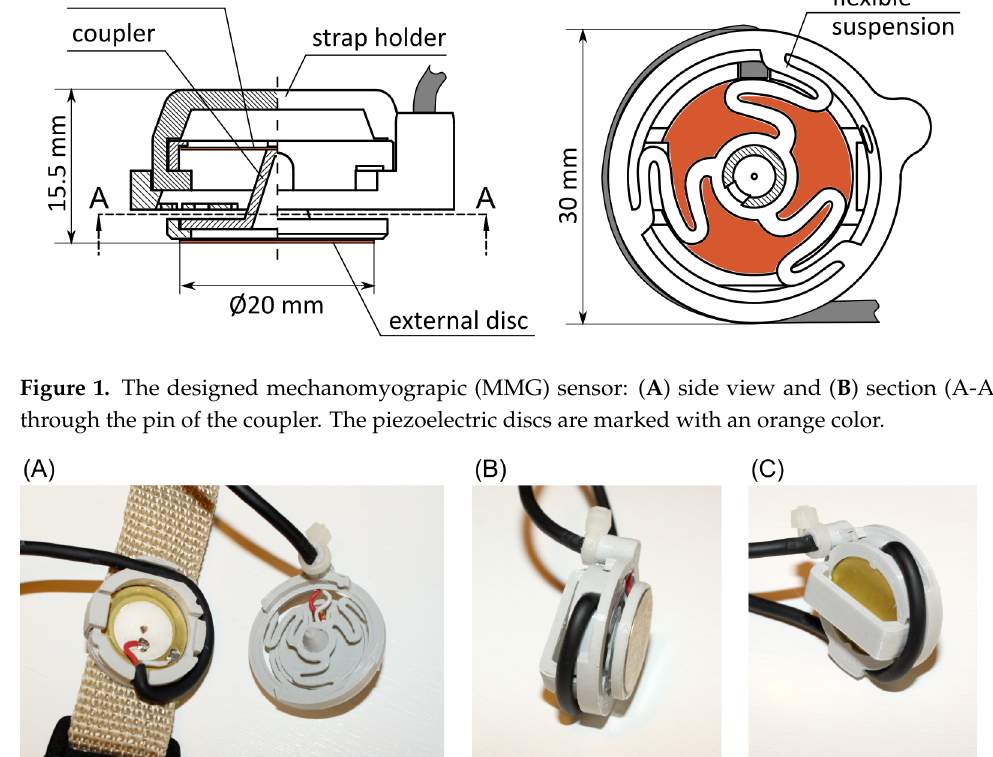
Figure 2. ( A ) The sensor before its final assembly. Two-core shielded microphone cables are used for signal transmission. ( B ) Side view of the assembled sensor with the external piezoelectric disc visible. ( C ) Side view of the assembled sensor with the internal disc